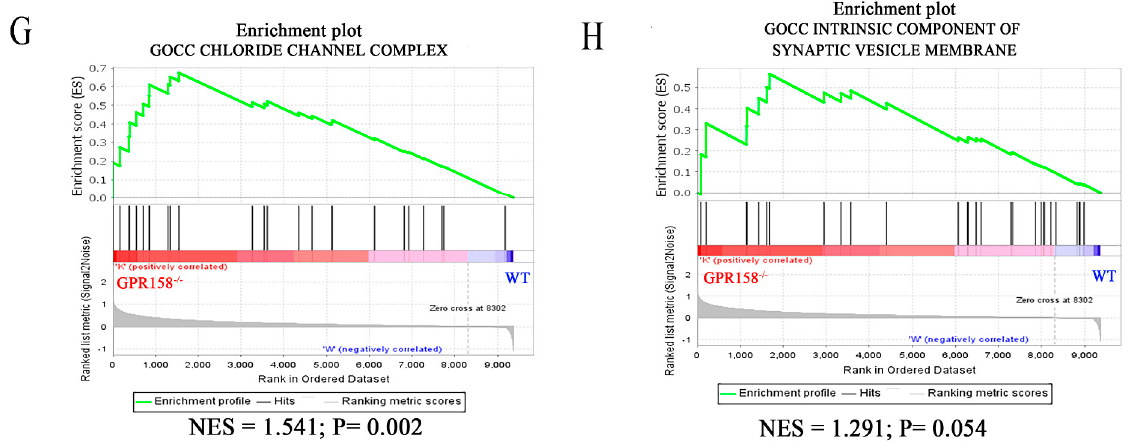
Figure 7. Identification and analysis of GPR158 interactors that displayed altered linear correlations and signaling pathways upon knockout of GPR158. ( A ) A network of proteins that may interact with GPR158 according to mass spectrometry analysis, established using a STRING database. According to the k-means algorithm, the proteins that may interact with GPR158 were classified into three clusters (WT mice, n = 3; GPR158 Tag mice, n = 3; male; See Supplementary Figure S4 for the screen- ing process used to identify proteins that may interact with GPR158). ( B ) Analysis of subcellular localization of GPR158 and its potential interacting proteins obtained from GPR158 Tag mouse protein spectrum data using the STRING database. ( C ) Bubble plot showing that GPR158 and its potential interacting proteins were enriched in multiple synaptic-function-related pathways in mammalian phenotype ontology. ( D ) Volcano plot revealing significantly differentially expressed genes in the cerebral cortex transcriptomes of GPR158 − / − mice vs. WT mice (WT mice, n = 5; GPR158 − / − mice, n = 5; male; criteria for determining significantly differentially expressed genes, p < 0.05, |log 2 FC| = 0.5). ( E , F ) A Pearson correlation coefficient network of proteins that may interact with GPR158 in the cerebral cortex of WT ( E ) and GPR158 − / − ( F ) mice. Pearson correlation coefficient anal- ysis was performed using FPKM (fragments per kilobase million) values from the RNA sequencing of WT ( E ) and GPR158 − / − ( F ) mice (WT mice, n = 5; GPR158 − / − mice, n = 5; male; red lines represent positive correlations, green lines represent negative correlations, and thicker lines represent larger Pearson correlation coefficients). ( G , H ) Gene set enrichment analysis (GSEA) of genes enriched in Gene Ontology Cellular Component pathways in the cortical RNA sequences of WT and GPR158 − / − mice (G: GPR158 − / − vs. WT, NES (normalized enrichment score) = 1.541, p = 0.002; H: GPR158 − / − vs. WT, NES= 1.291, p = 0.054; WT mice, n = 5; GPR158 − / − mice, n = 5; male). Furthermore, we performed RNA sequencing of cortical tissue from WT and GPR158 − / − mice to observe any possible transcriptional effect of GPR158 knockout on the GPR158 interactors. The interactor volcano plot showed significantly differentially expressed genes ( p <0.05, |log 2 FC|=0.5) between WT mice and GPR158 − / − mice (Figure 7D). Next, we used the Pearson correlation coefficient to assess possible relationships between GPR158 and its interactors. Strikingly, we found that knockout of GPR158 profoundly strengthened the correlations among GPR158 interactors compared to the WT group (red lines represent positive correlations, green lines represent negative correlations, and thicker lines represent higher Pearson correlation coefficients) (Figure 7E,F). In addition, gene set enrichment analysis (GSEA) of the GPR158 − / − mouse cortical transcriptome revealed that GPR158 knockout significantly affected the chloride channel complex pathway in GOCC (NES (normalize enrichment score) = 1.541, p = 0.002) and also had a tendency to influence the intrinsic component of synaptic vesicle membrane pathway in GOCC (NES = 1.291, p = 0.054; Figure